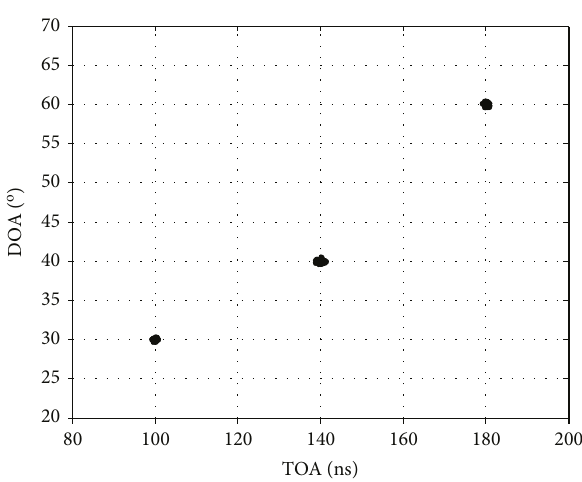
Figure 3: The scatter plot of joint TOA and DOA estimation, SNR =5dB.